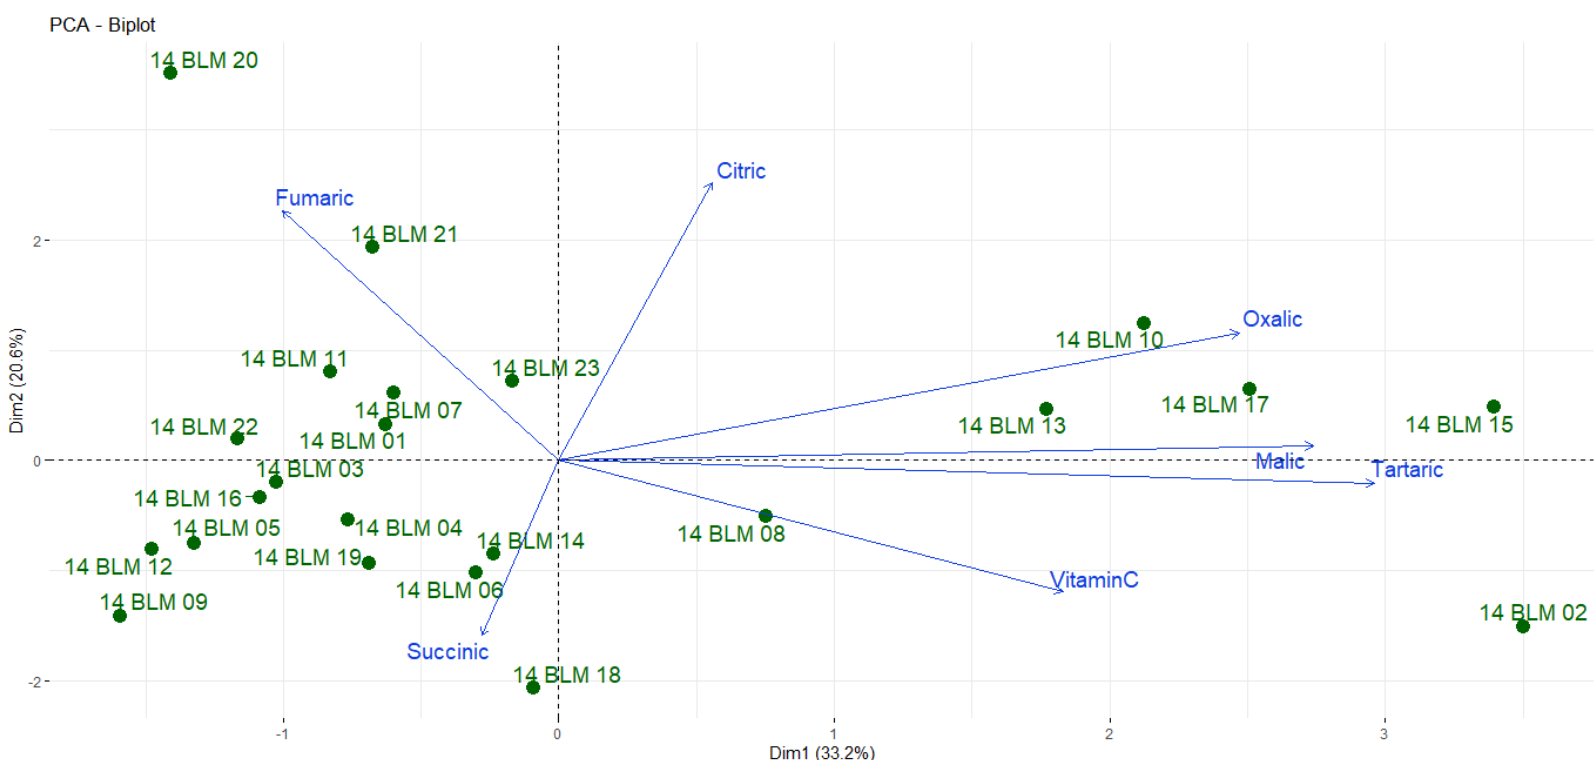
Figure 3. Distribution of plum genotypes according to organic acids and vitamin C contents.